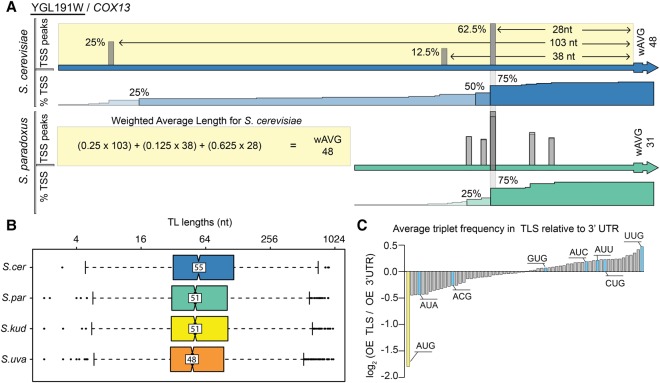
Transcript leader evolution in Saccharomyces sensu stricto. (A) An example comparison of TLs of COX13 (YGL191W) from S. cerevisiae and S. paradoxus is shown. Although the most frequent TSS has been conserved (28 nt TL), the most upstream TSS has diverged. The weighted average (wAVG) length for each transcript leader was calculated to compare transcript leader lengths among species. (B) S. cerevisiae has significantly longer TLs than the other species. (C) The observed/expected ratio (OE) of each 3-nt triplet in 5′ UTRs versus 3′ UTRs is plotted. Relative to the 3′ UTR, the TLSs are de-enriched in AUG triplet nucleotides (black), and enriched in five of seven near-cognate codon (NCC) triplets (gray). The data presented are an average of values from the four species; individual values are plotted in Supplemental Figure S14.